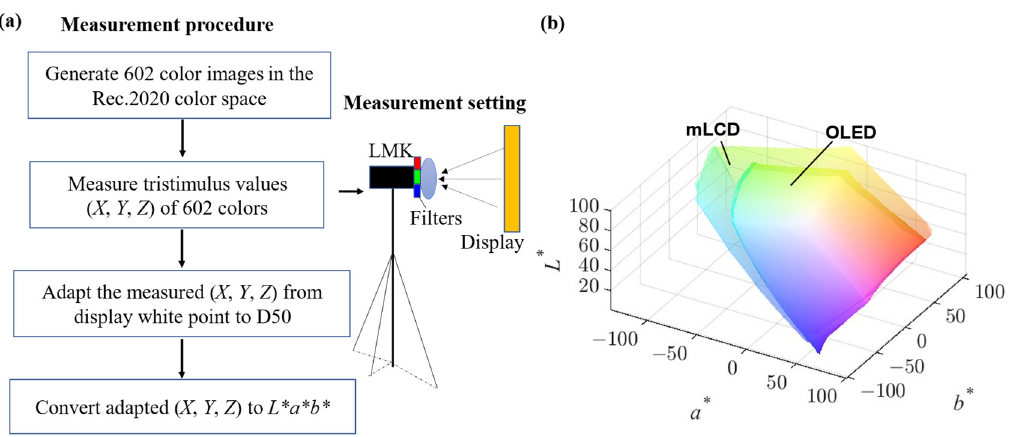
Figure 4. ( a ) Measurement procedure and setting for the color gamut volume and ( b ) measured color gamut volumes of the mLCD and the OLED display.